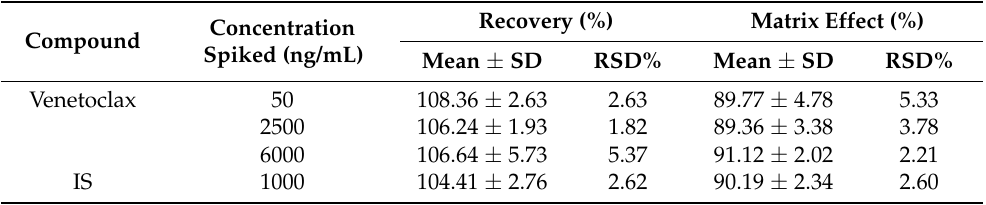
Table 3. Extraction recovery and matrix effect of venetoclax and IS (mean ± SD, n = 6).